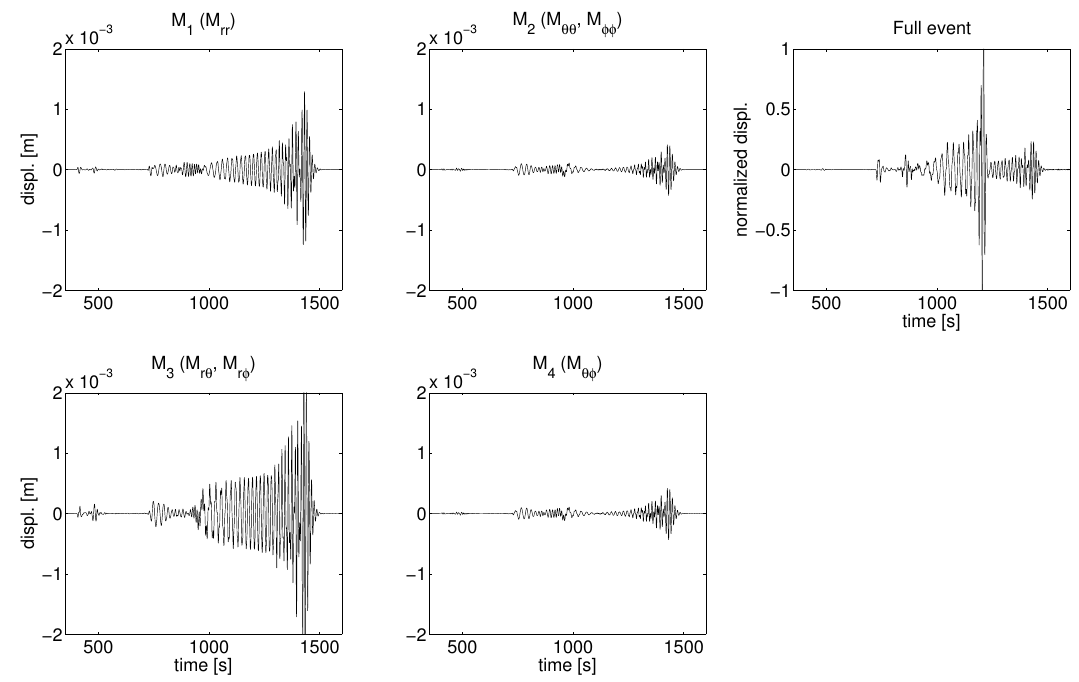
Figure 7. Left quadrant: The four time series upon the generic moment-tensor types (see Eqs. 9–12). Right: Summation to the full seismogram for the 2011 M9 Tohoku (point-source) event. Plotted is the displacement in the s direction (i.e., perpendicular to the symmetry axis, see Fig. 3), with a dominant period of 10s recorded at station BILL (East Siberia) at 33 ◦ distance.